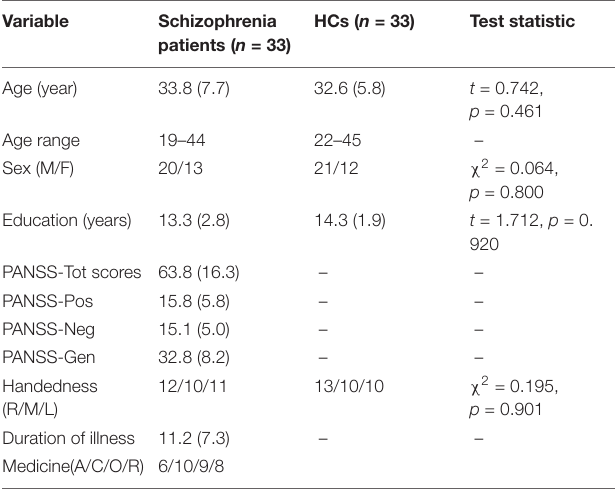
TABLE 1 | Demographic characteristics and clinical information of participants [mean (SD)].